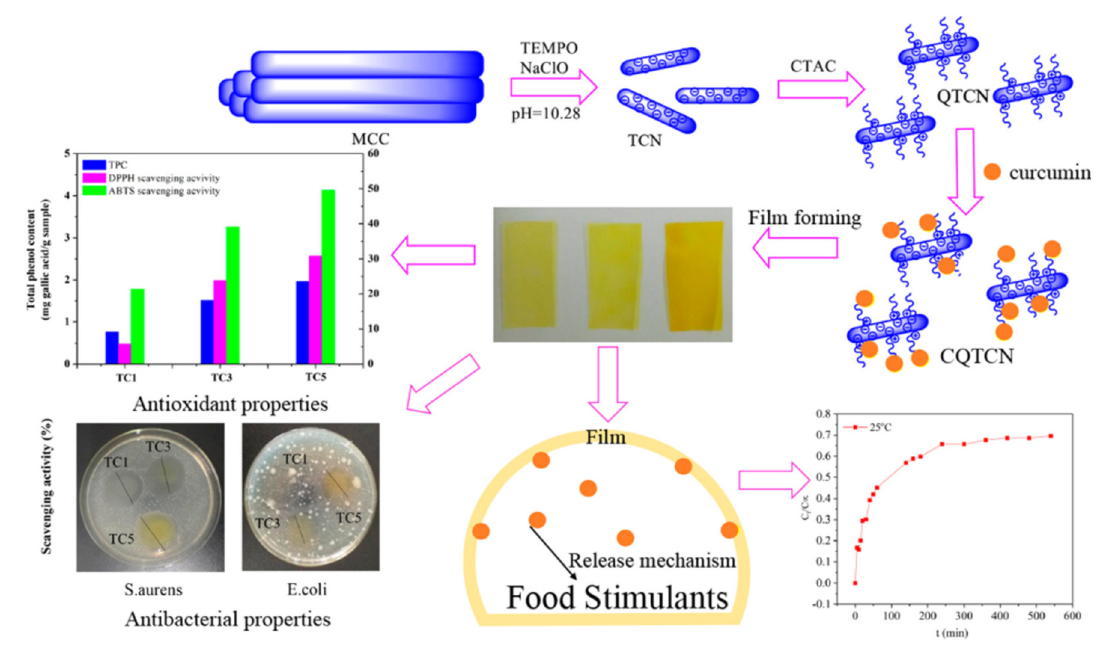
Figure 8. Schematic illustration of curcumin-loaded membrane and the drug release curve of curcumin